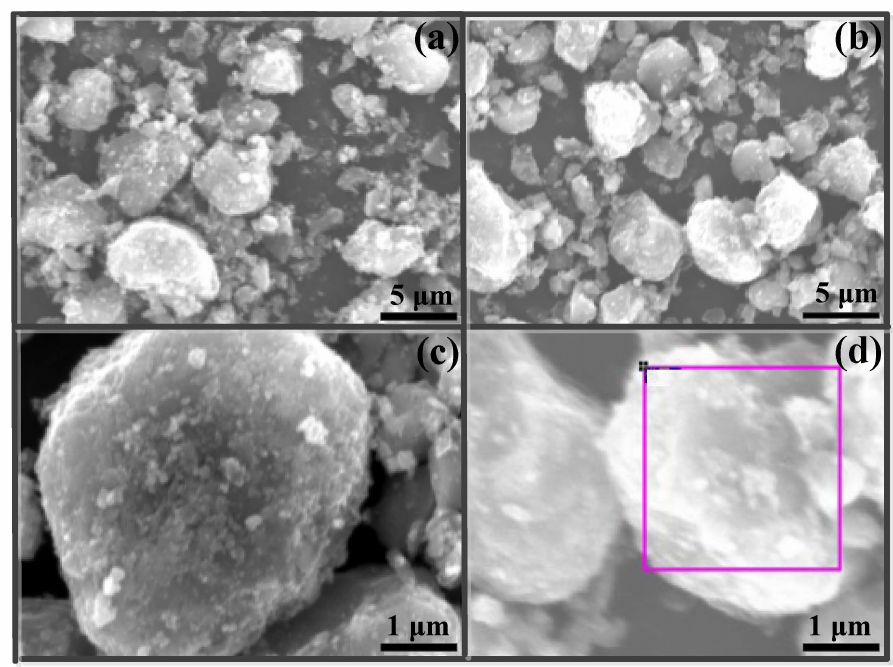
Figure 6. SEM images of 8%Fe 3 O 4 @MMC adsorbent: ( a ) fresh, × 5000; ( b ) after adsorption, × 5000; ( c ) fresh, × 25,000; and ( d ) before adsorption, × 25,000, pink frame represents selected area for